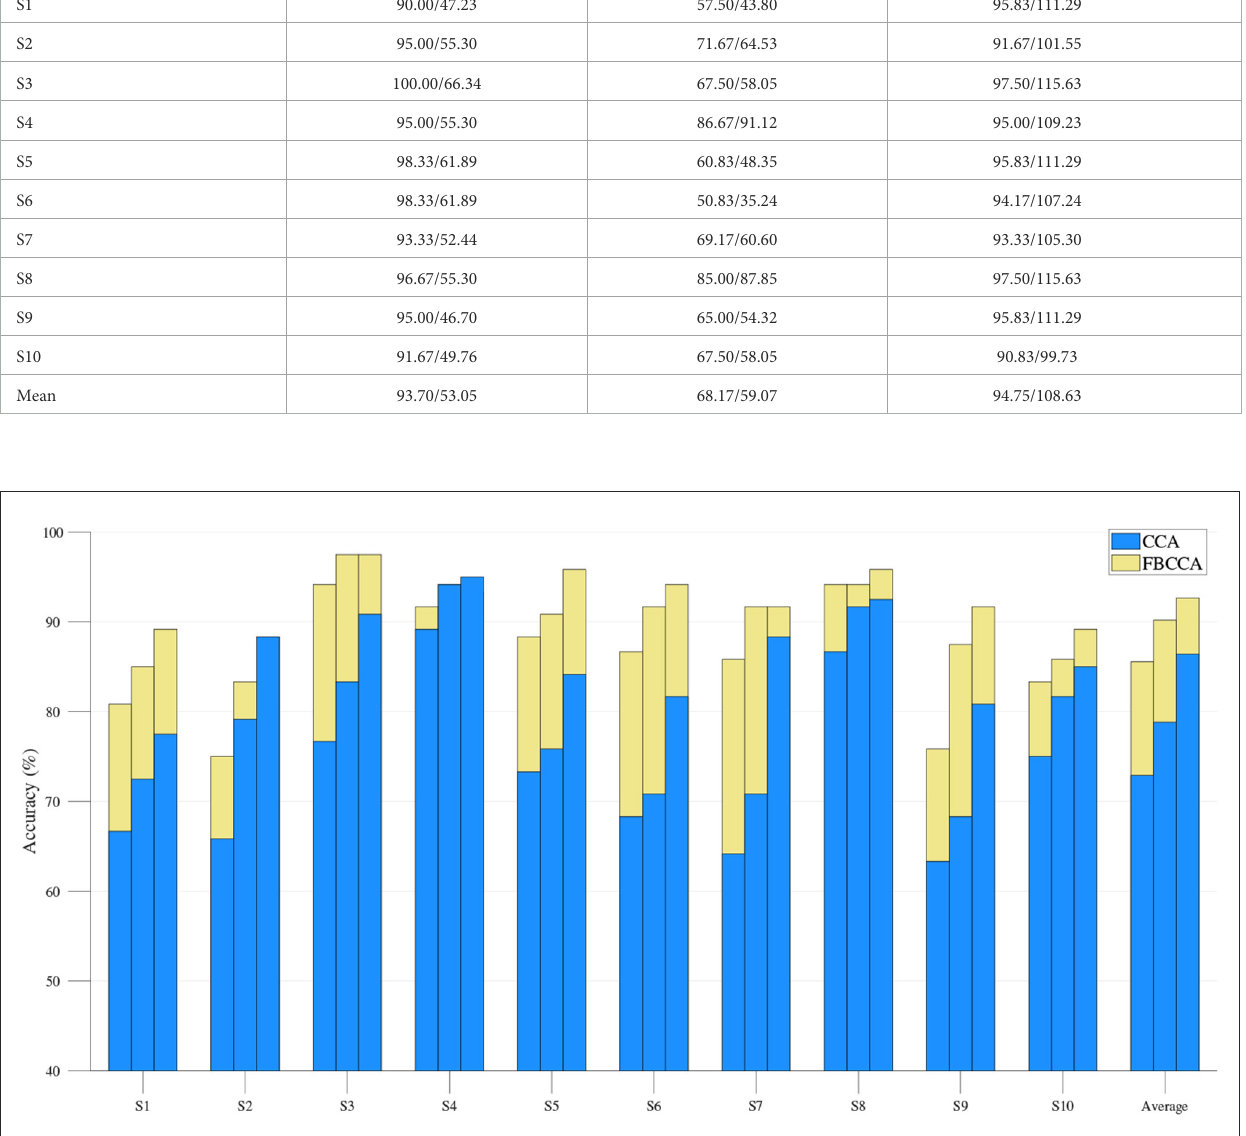
FIGURE12 Offline classification accuracy of CCA and FBCCA methods at different window lengths. Three bars in each experiment indicated three window length from 0.8 s (left) to 1.2 s (right) at a step of 0.2 s. The blue and yellow bars show the results of the CCA and FBCCA,